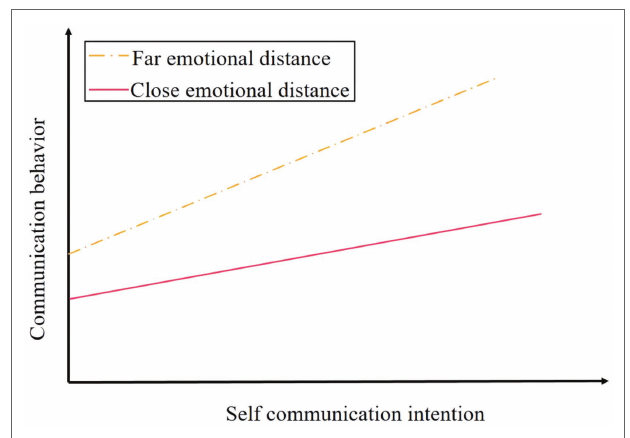
FIGURE 5 | Positive moderating effect of emotional distance.